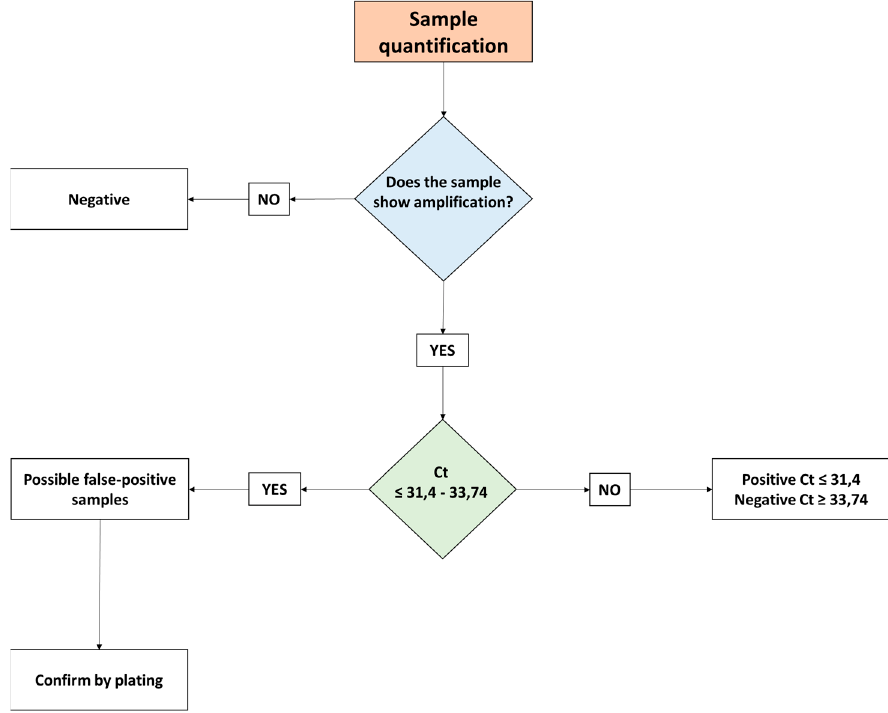
Figure 3. Decision diagram for quantification of samples according to the detection limit. Table 1. Reproducibility of the real-time PCR method for the invA